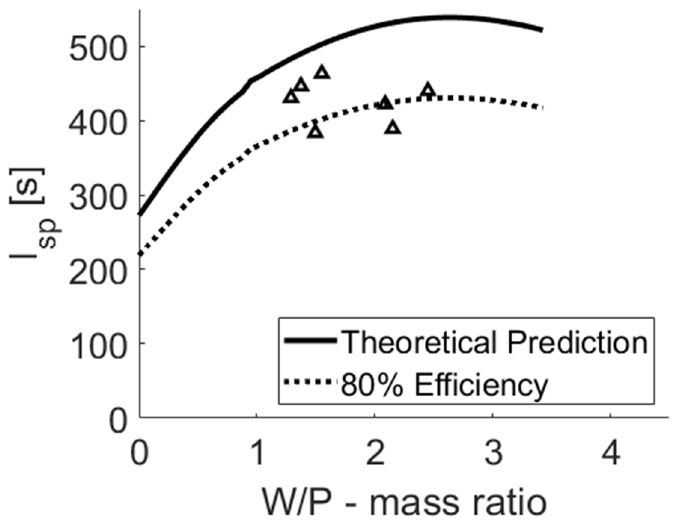
Figure 7. Theoretical and static firing test results of the standard specific impulse vs. the water– propellant mass ratio for a hybrid-propellant, water-breathing ramjet fueled with 70% polyester and 30%